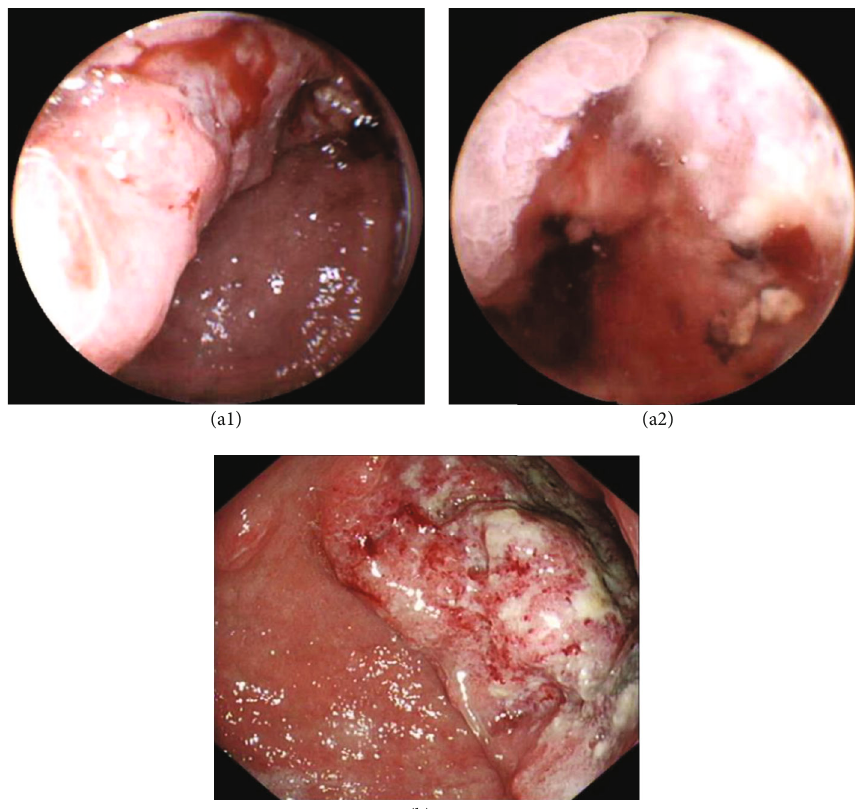
Figure 4: Poorly di ff erentiated adenocarcinoma on the angle of the stomach identi fi ed by MCCG (a) and con fi rmed with biopsy from following C-EGD